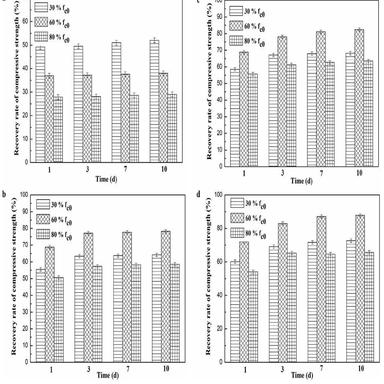
Compressive strength recovery rate of mortars containing different microcapsules. a. AM0, (b) AM1, (c) AM2, (d) AM3.